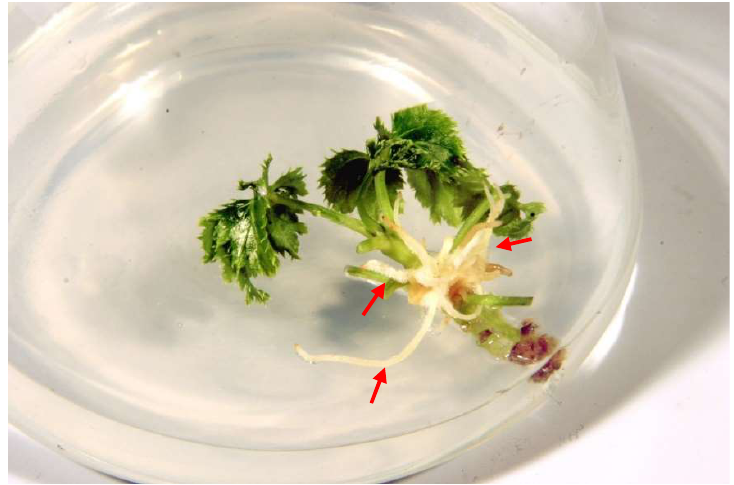
Figure 1. Roots emerging from infected Agrobacterium rhizogenes ATCC 15834 shoots after 4 weeks of culture. Shoots were cultivated on hormone-free MS solid medium supplemented with acetosyringone. Table 1. Efficiency of hairy root formation on various explants infected with Agrobacterium